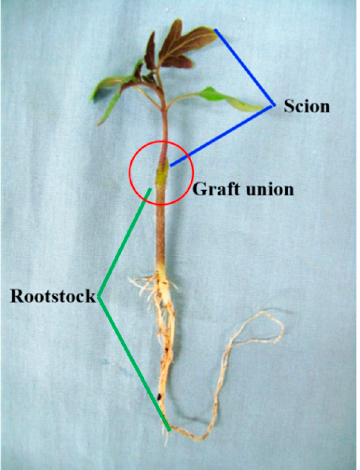
Figure 1. Grafting method used for tomato plug seedlings.